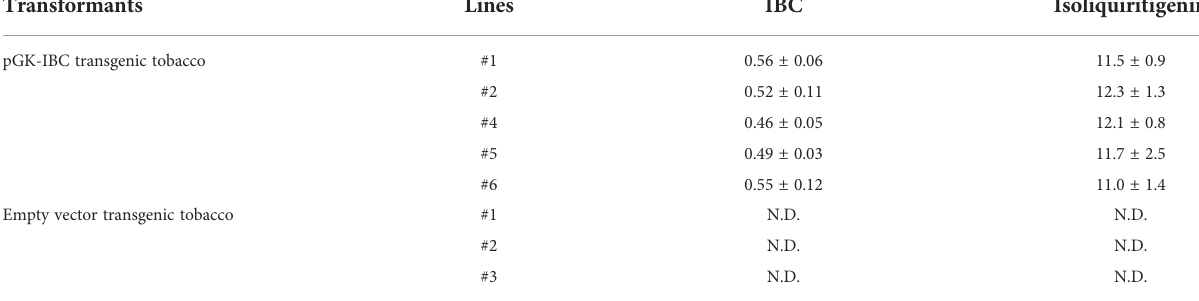
Values shown are the concentration of isobavachalcone (IBC) and liquiritigenin ( m g/g dry weight). Values are the mean of fi ve biological replicates ± standard error. N.D., not